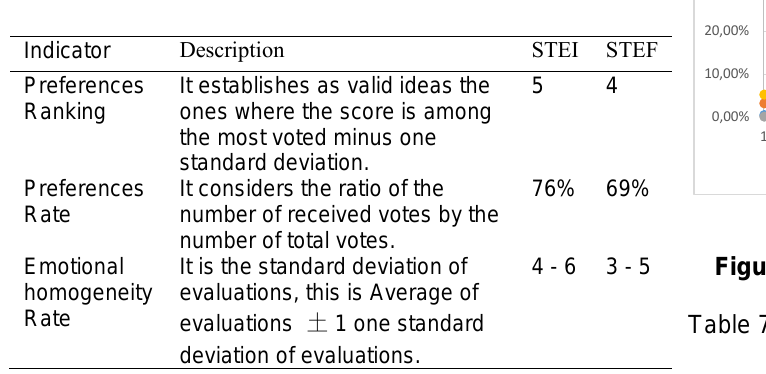
Table 5. Indicators of Early Childhood education (STEI), & Science of Physical Activity and Recreation Sports (STEF).